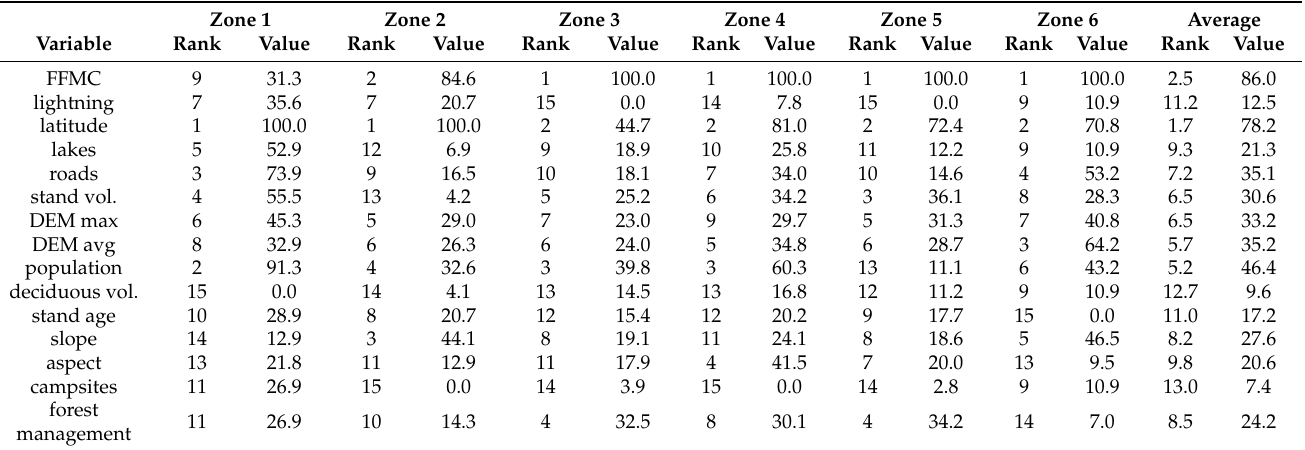
Table 3. Random forest variable importance in each vegetation